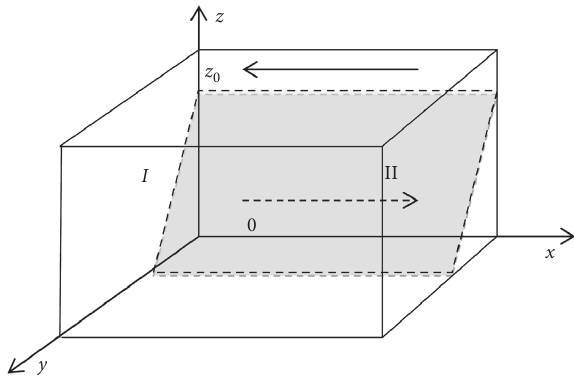
Figure 1: The government’s dynamic